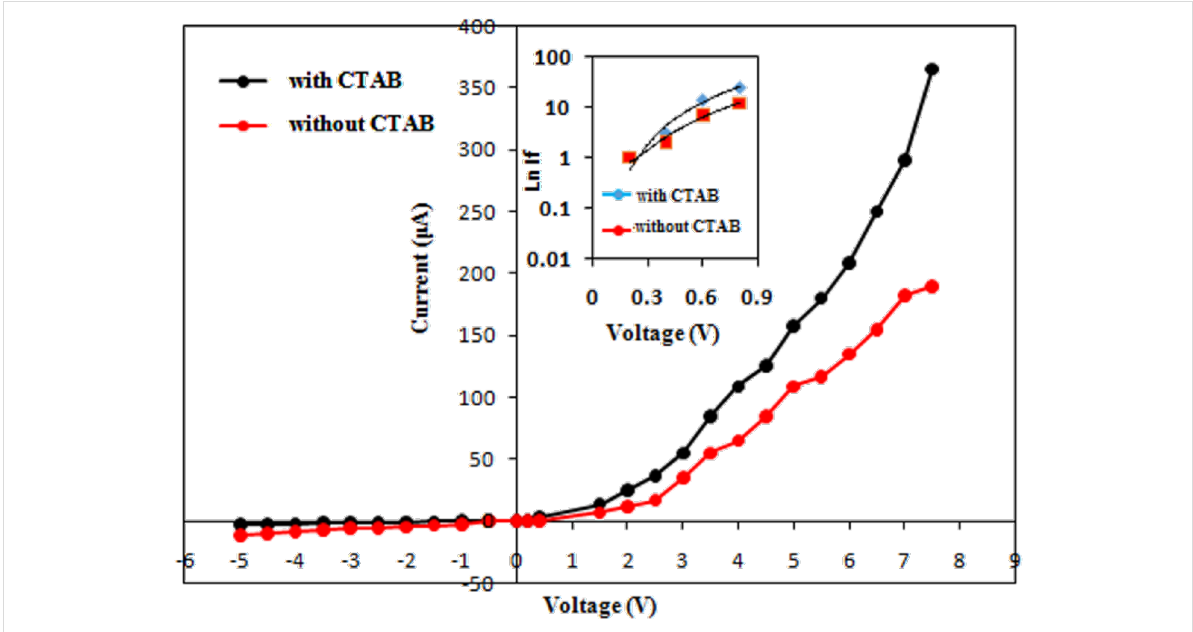
Figure 11: Dark I – V characteristics of n-Ag 2 S/p-Si heterojunction prepared with and without CTAB. Inset is the semi-logarithmic of forward versus voltage plot.